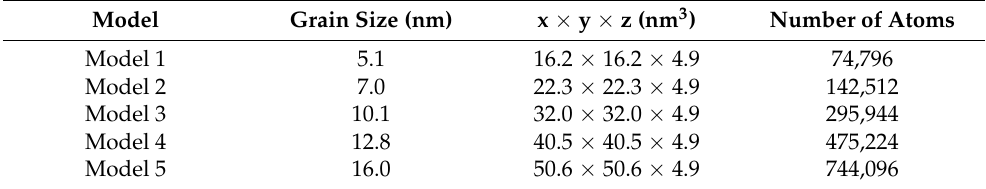
Table 2. Parameters of models with various grain sizes.